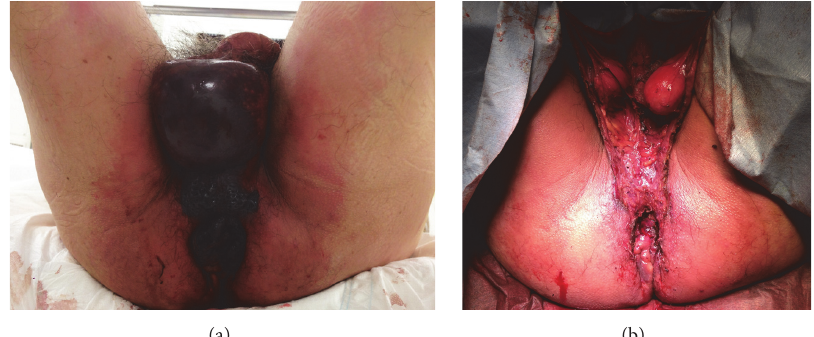
Figure 1: (a) Necrotic incarcerated hemorrhoids and necrotic perineal tissues. (b) Wound after removal of necrotic hemorrhoids and debridement of necrotic tissues.